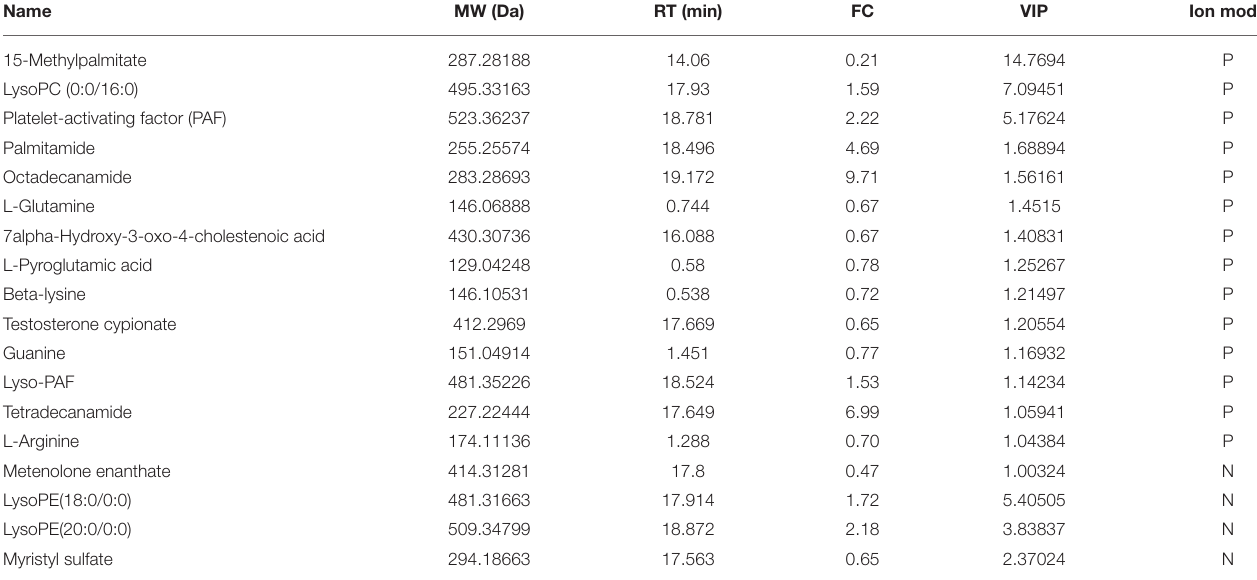
TABLE 4 | Information of 18 differential